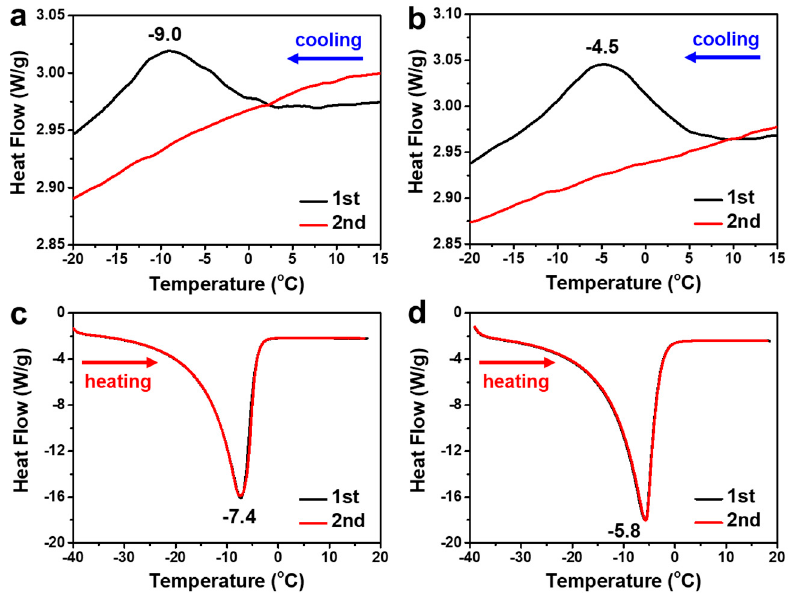
Figure 4. Magnified DSC profiles of cooling and heating thermograms of 5 wt% CC in ( a , c ) 7 wt% NaOH and ( b , d ) 7 wt% NaOH/1.6 wt% ZnO aqueous